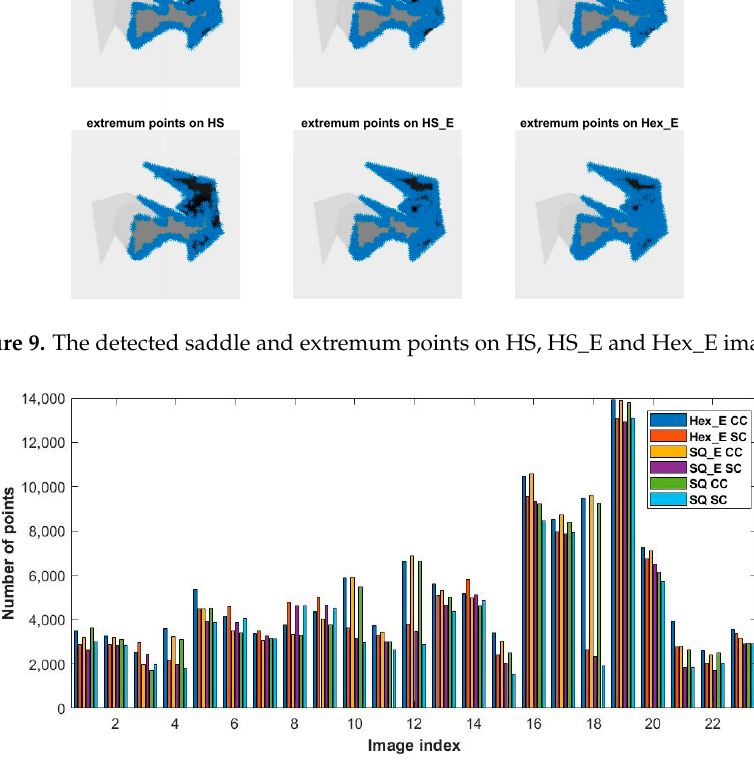
Figure 10. The number of the saddle and extremum points in each SC and CC image having Hex_E, SQ_E and SQ image types.